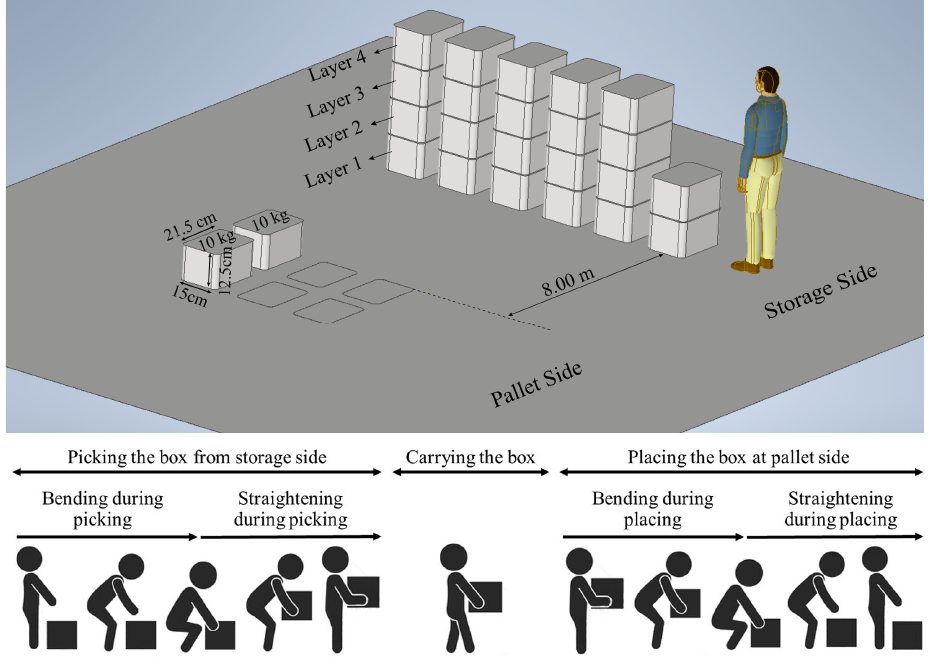
Figure 1. The ( upper ) panel shows the schematic of the experiment area with the pallet and storage locations. The distance between two locations were 8 m apart and each box weighed 10 kg. The ( lower ) panel shows the sequence of bending and straightening during picking and placing at the storage and pallet sides.